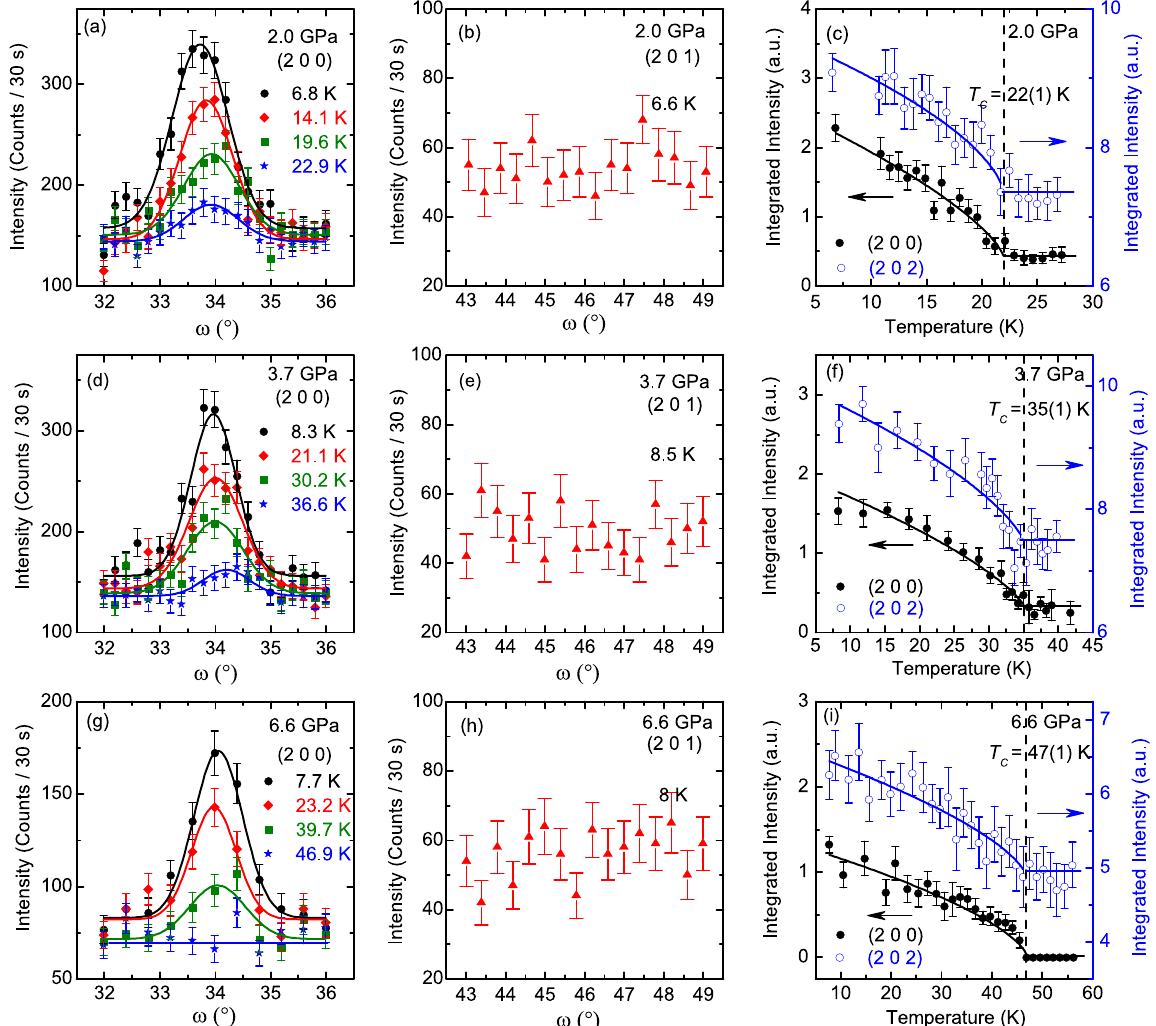
Figure 6. The summary of the neutron diffraction data on the Eu(Fe 0.925 Co 0.075 ) 2 As 2 single crystal measured under the high pressure at 2.0 GPa ( a – c ), 3.7 GPa ( d – f ) and 6.6 GPa ( g – i ), respectively. The rocking scans of the (2 0 0) and (2 0 1) reflections at different temperatures measured at 2.0 GPa, 3.7 GPa, and 6.6 GPa are shown in ( a , b , d , e , g , h ), respectively. The solid curves represent the fits using the Gaussian profiles. The integrated intensity of the (2 0 0) and (2 0 2) peaks under different pressure values are plotted as functions of the temperature in ( c , f , i ), respectively. The vertical dashed lines mark the ferromagnetic transition temperatures of Eu at different pressures and the solid lines are guides to the